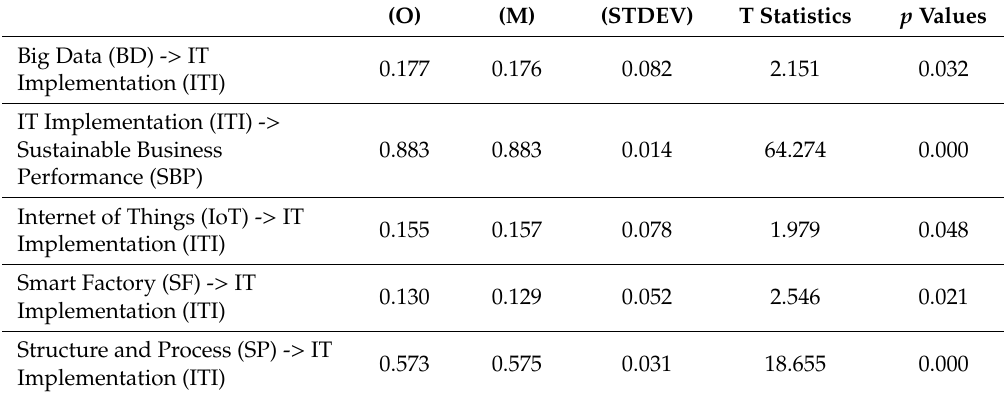
Figure 8. Structural Model Assessment. Table 6. Direct Effect Results.